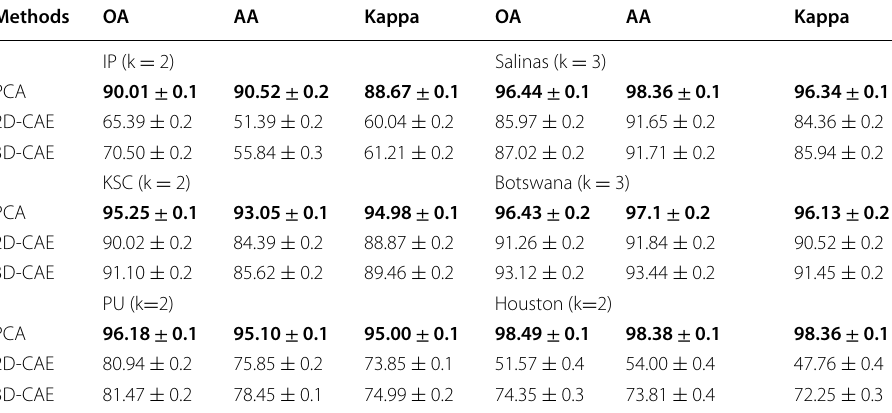
Table 3 Experimental results of our feature reduction techniques between PCA, 2DCAE, and 3DCAE. An explanation of the metrics can be found in "Experiment configurations" section